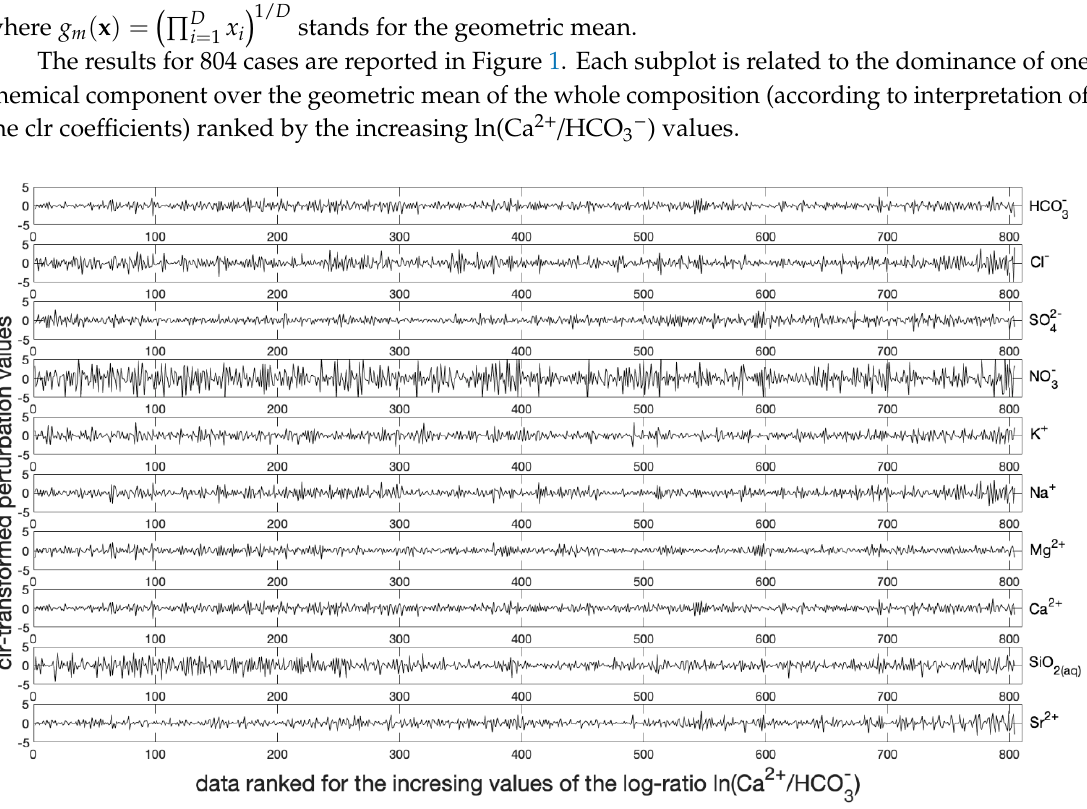
Figure 1. Pattern of the clr-perturbation-subtraction values for each variable after having ranked the data matrix for increasing values of the log-ratio ln(Ca 2+ /HCO 3 − ).